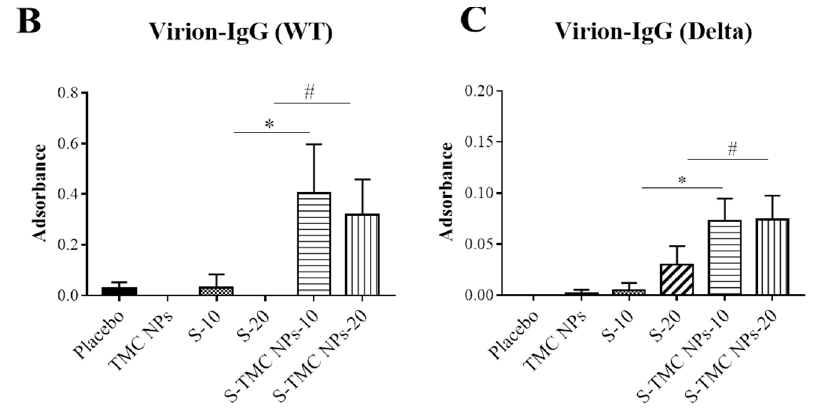
Figure 6. Mucosal responses to soluble S-protein or S-TMC NPs in the BALs of immunized mice. BALs were harvested from immunized mice on Day 45 and subjected to quantitation of anti-S and anti-RBD IgG antibodies using indirect ELISA ( A ). BALs diluted at 1:10 were analyzed for virion–IgG capture ELISA assays against WT SARS-CoV-2 ( B ) and the Delta variant strain ( C ). The results are shown as means ± SD ( n = 4); * and # indicate a significant difference between the mice immunized with soluble S-protein and S-TMC NPs at 10 and 20 μ g/dose, respectively ( p < 0.05).